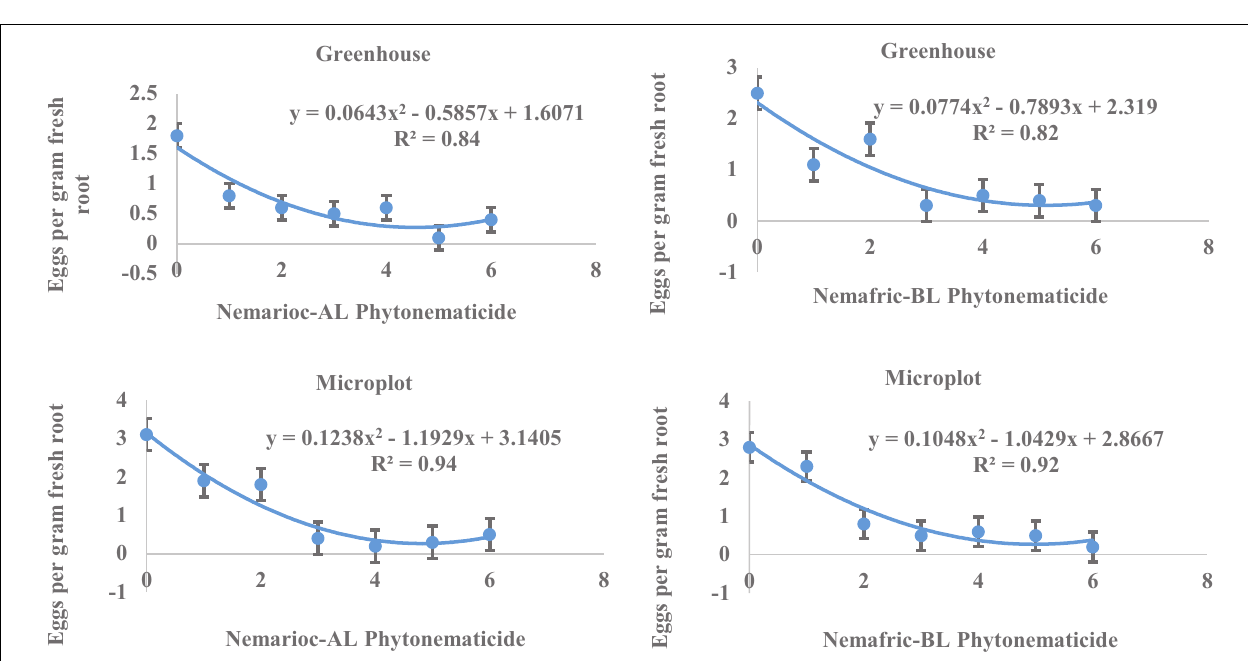
FIGURE 1 | Response of M. incognita root galls in pea seeds primed in cucurbitacin phytonematicides from root of plants raised in greenhouse and microplot conditions (Bar represents mean ± standard error) (The x-axis comprised transformed data, where 0 = 0, 1 = 2, 2 = 4, 3 = 8, 4 = 16, 5 = 32, and 6 = 64% phytonematicide).